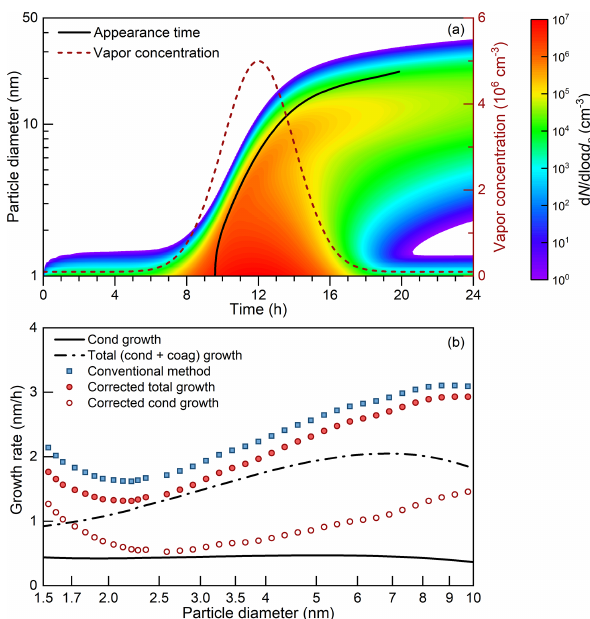
Figure 7. The appearance time method under a varying vapor con- centration. The test condition is summarized in Table A1, no. 8. (a) An NPF event simulated using a discrete-sectional aerosol dy- namic model. The vapor concentration is assumed to follow a normal distribution (with a background value of 10 5 cm − 3 ) . The 100nm background particles are not shown. The particle diame- ter as a function of the appearance time is shown as the solid line. (b) The theoretical and retrieved particle growth rates. The terms cond and coag are short for condensation and coagulation, respec-